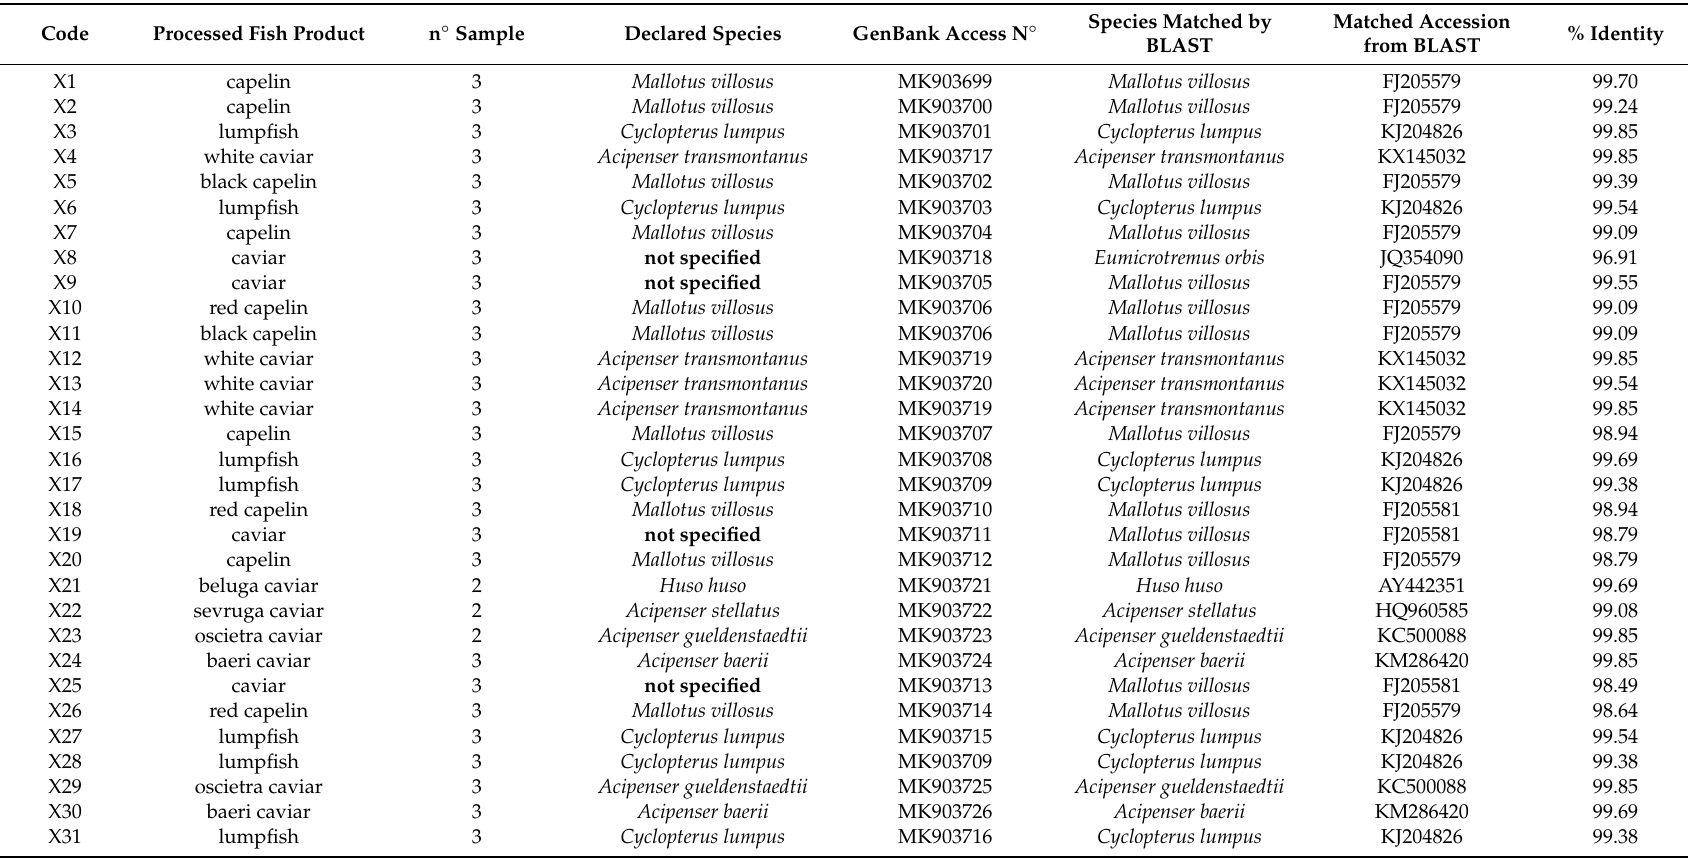
Table 2. Samples of caviar and caviar substitute included in this work. In bold mislabeled seafood